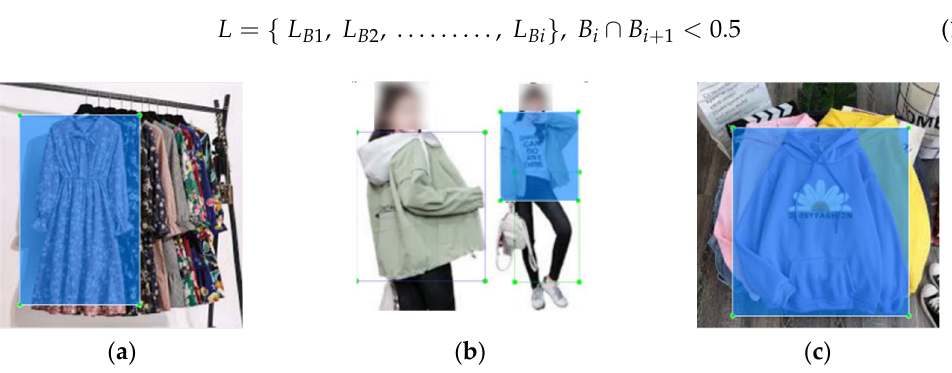
Figure 3. Image Labelling Process. ( a ) Overlapping Dress Image; ( b ) Multiple Category Within One Image; ( c ) Overlapping Hoodie Image.